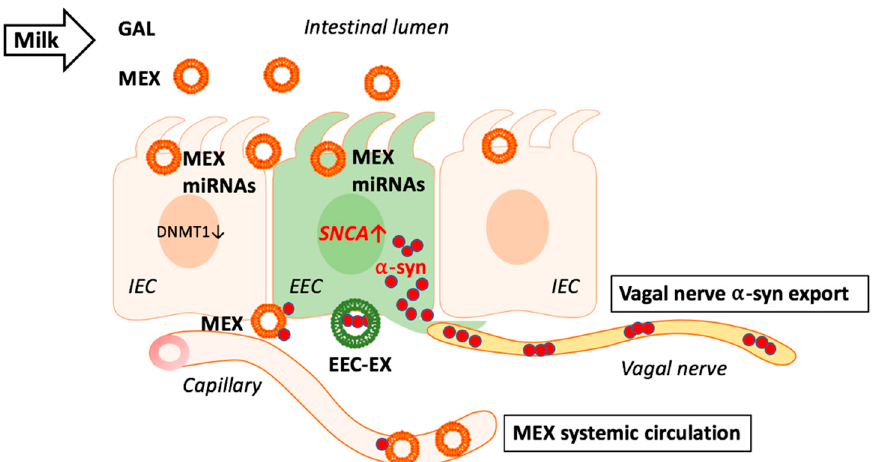
Figure 1. Milk exosomes (MEX) are taken up by intestinal epithelial cells (IEC) and suppress DNA methyltransferase 1 (DNMT1) resulting in promoter hypomethylation of DNMT1-methylated genes. Potential MEX uptake by adjacent enteroendocrine cells (EEC) may as well reduce DNMT1 resulting in SNCA promoter hypomethylation increasing the expression of α -synuclein ( α -syn). Excessive or aggregated α -syn may leave EECs via the vagal nerve and/or MEX as well as EEC-derived exosomes (EEC-EX). MEX that reach the systemic circulation and brain may in addition transport outer exosome membrane-attached α -syn to target tissues.